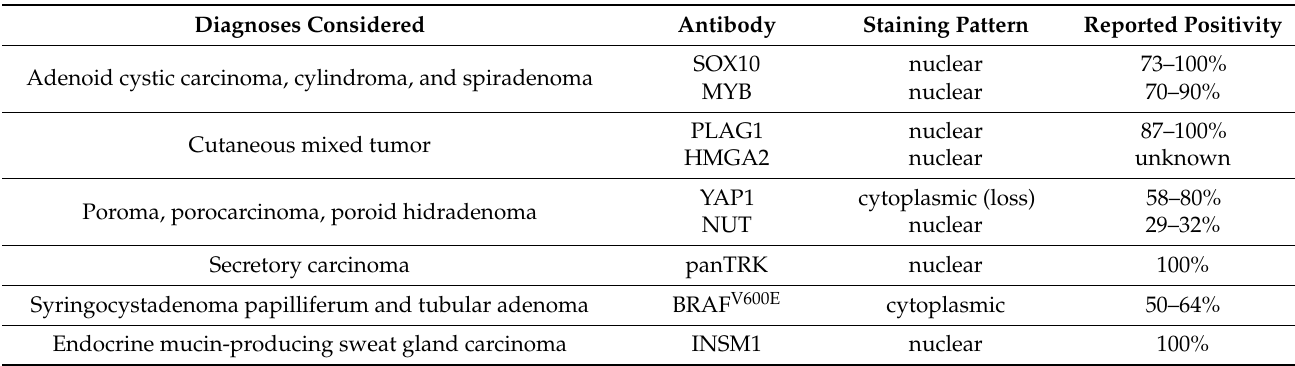
Table 1. Most recent immunohistochemistry used for the diagnosis of skin adnexal neoplasms with sweat gland differentiation.